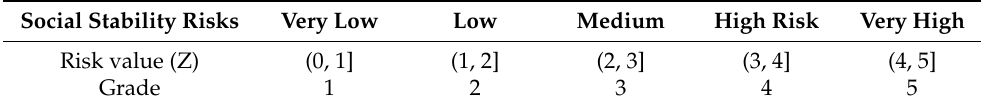
Table 2. Social stability risks’ level and reference